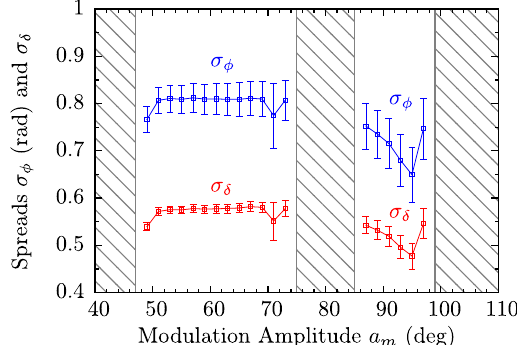
FIG. 11. The rms bunch spreads σ ϕ and σ δ as a function of ¼ 30 °. The hatched region modulation amplitude a , where Δ ϕ m o depicts the approximate regions where no diffusion was observed. ∼ 115 °, particle loss occurs. Beyond a m